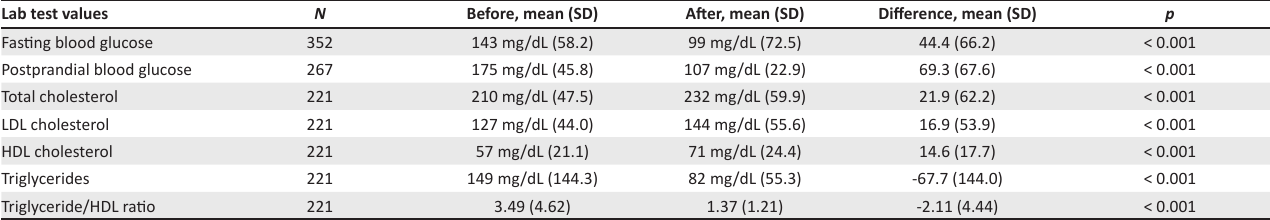
TABLE 3: Lab test values before and after low-carbohydrate diet initiation. Lab test values